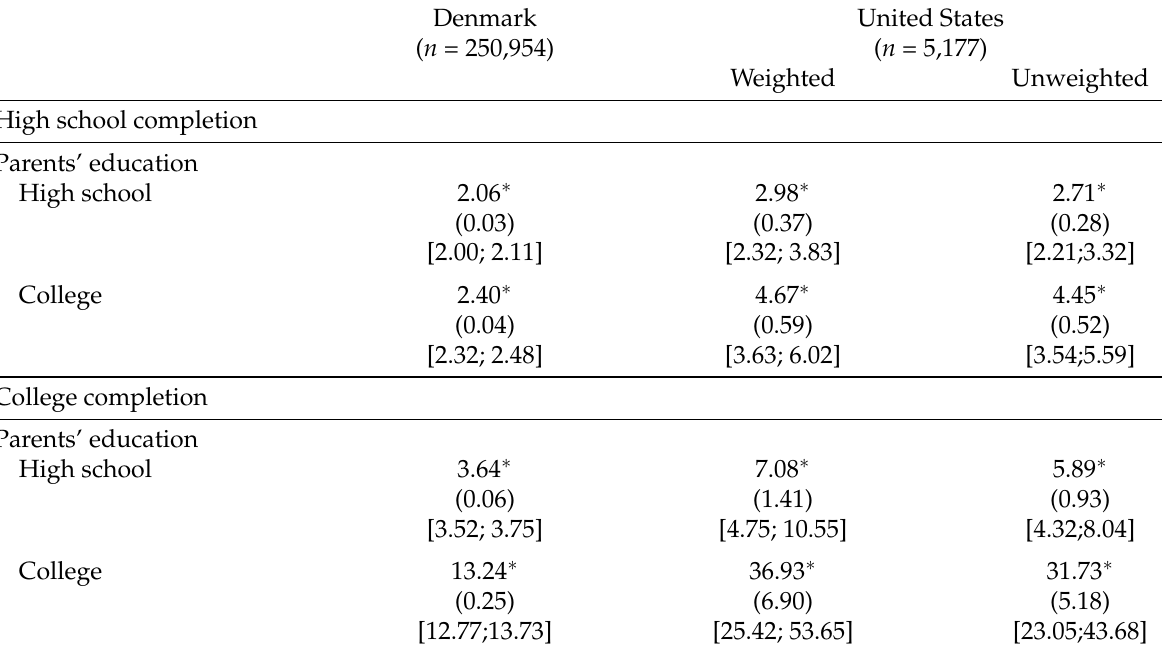
Table 3: Educational mobility by categorical measures: children’s degree by parents’ highest